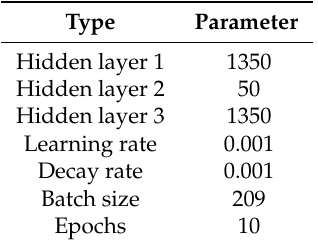
Table 2. Parameters of the